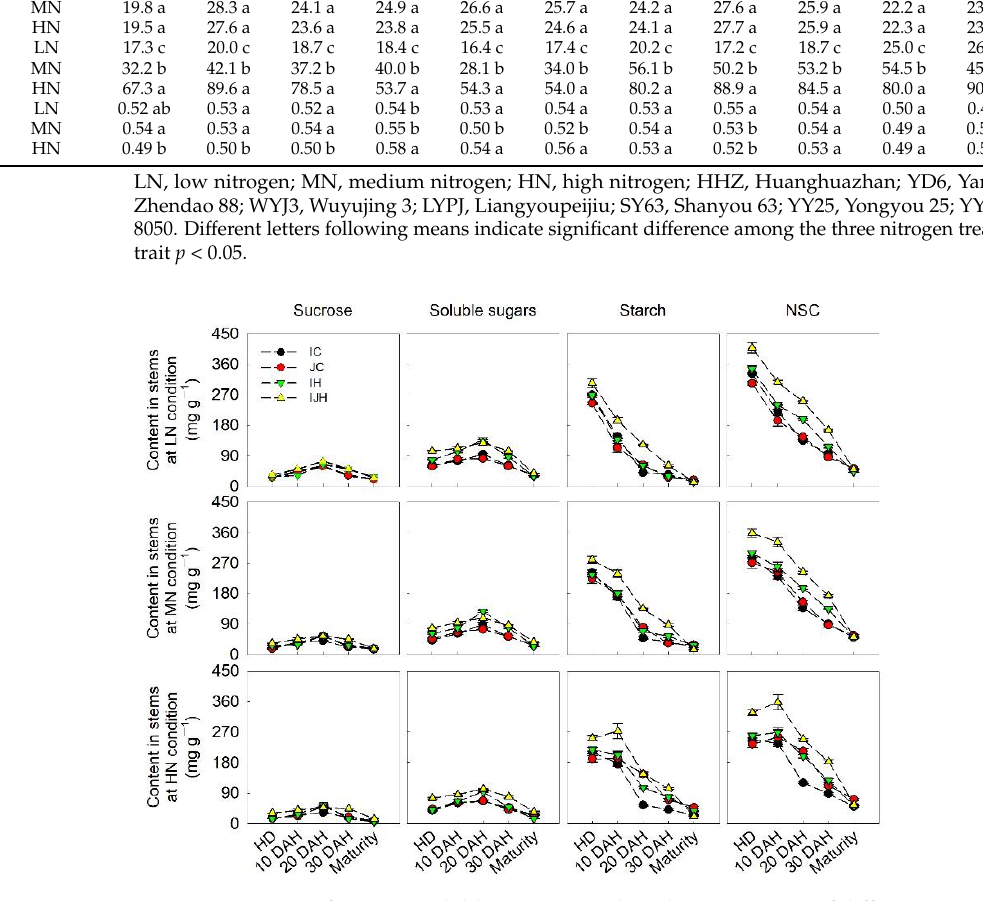
Figure 1. Content of sucrose, soluble sugars, starch and NSC in stems of different rice varieties under different nitrogen application levels. IC, indica conventional rice; JC, japonica conventional rice; IH, indica hybrid rice; IJH, indica-japonica hybrid rice; LN, low nitrogen; MN, medium nitrogen; HN, high nitrogen; HD, heading date; DAH, days after heading.